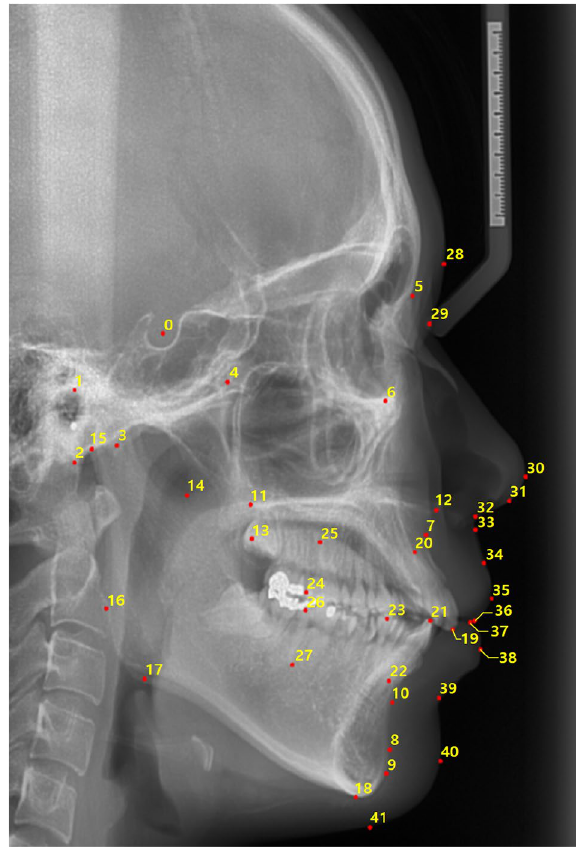
Figure 1. An example case of forty-two landmarks (numbered 0–41) in a cephalometric X-ray lateral image of size 2 k × 3 k pixel used in this study.